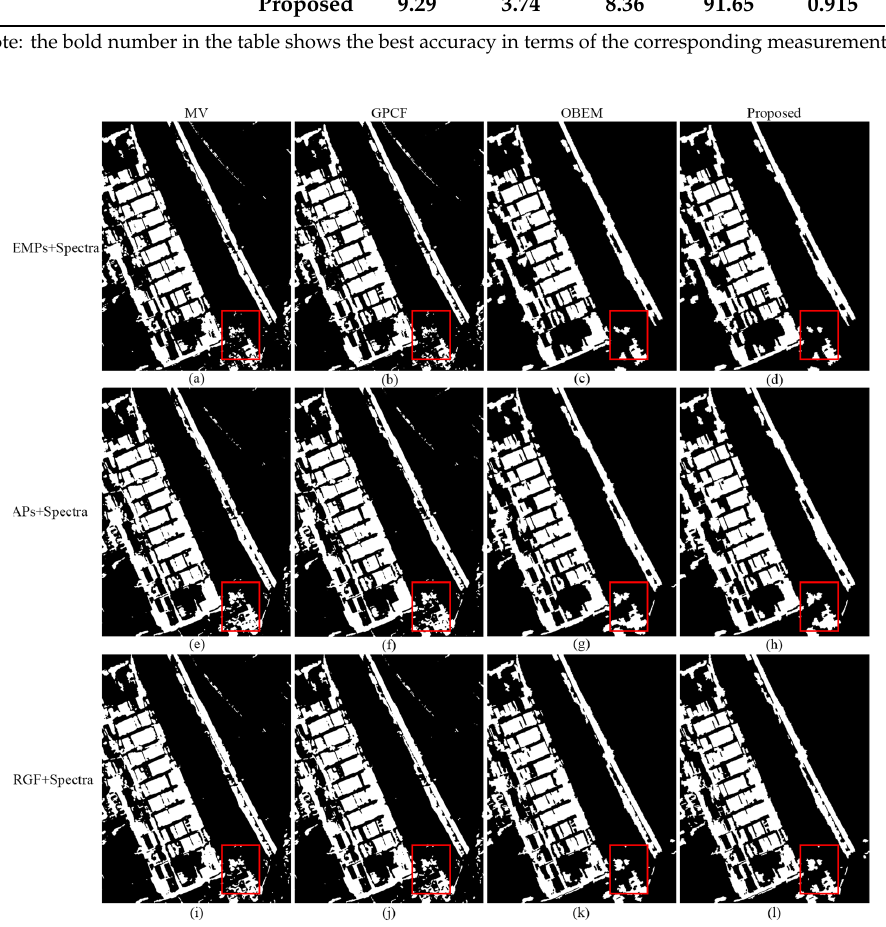
Figure 10. Visual comparison of the detection maps between the post-processing and the proposed approaches with different spatial–spectral feature fusion methods in the Ji’Nan QuickBird satellite images. The caption on the left shows which spatial–spectral feature was adopted in this row, and the caption on the top shows which post-processing approach the column adopted.